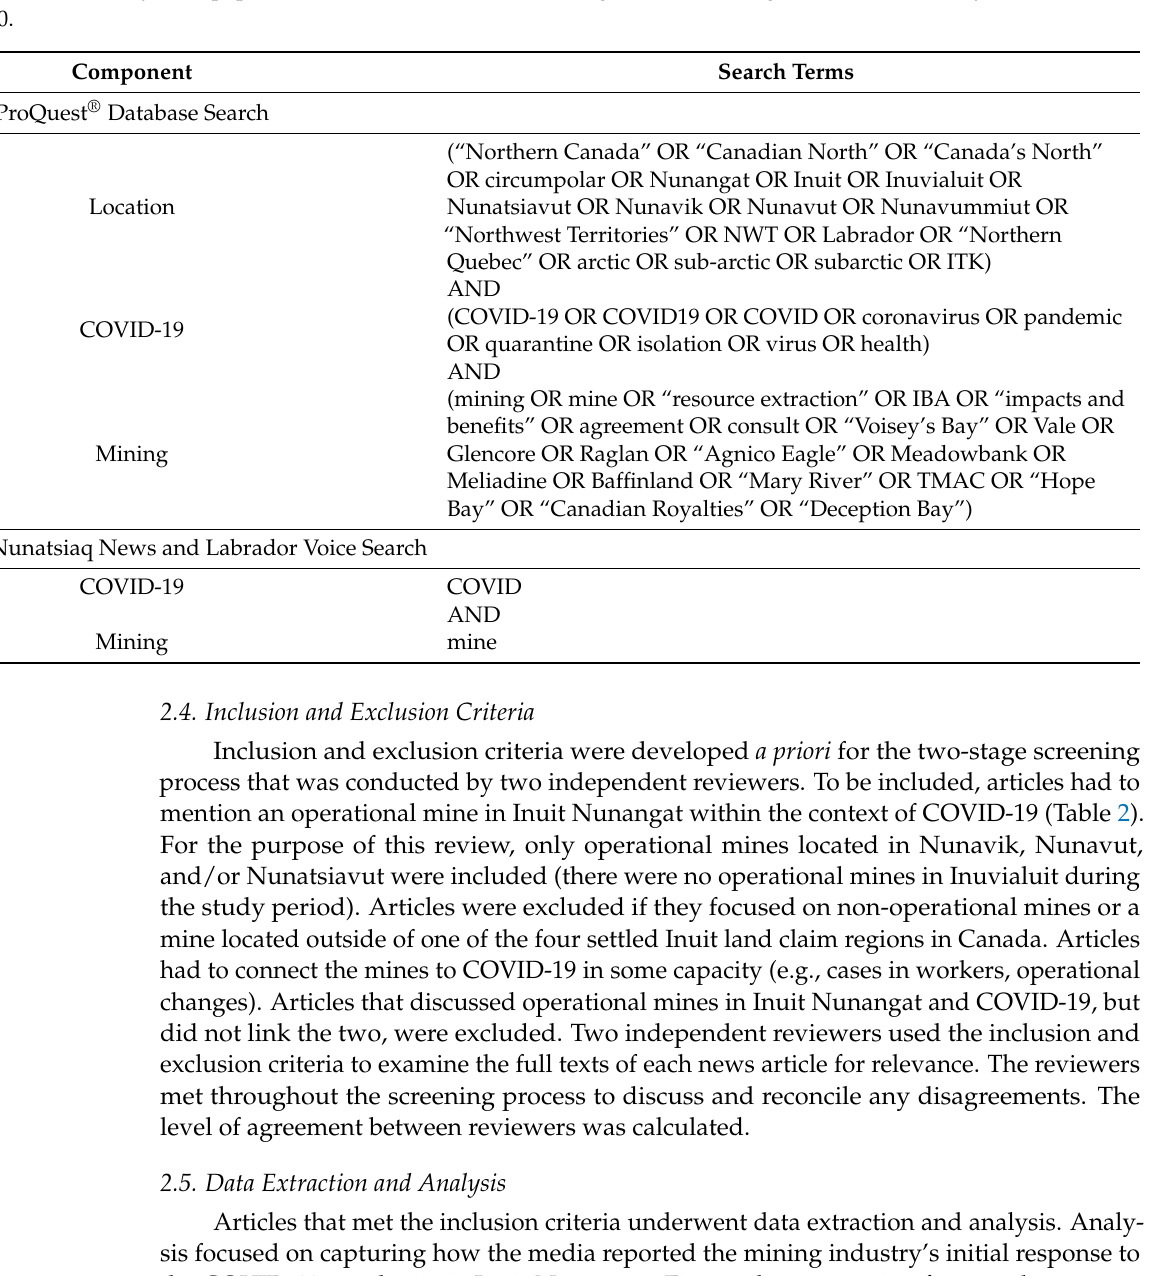
Table 1. Terms used to search ProQuest ® databases and local newspaper outlets (i.e., NNSL media, Nunatsiaq News